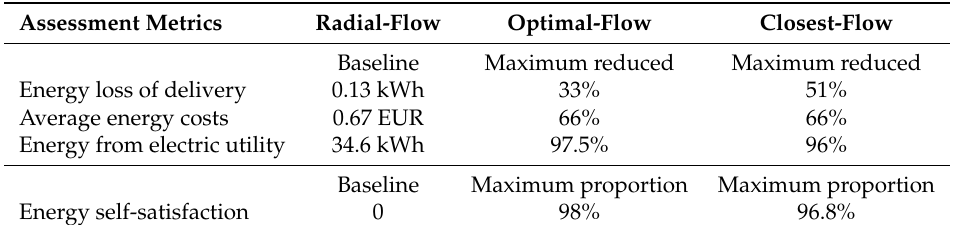
Table 2. Performance comparison with the evaluation cases.